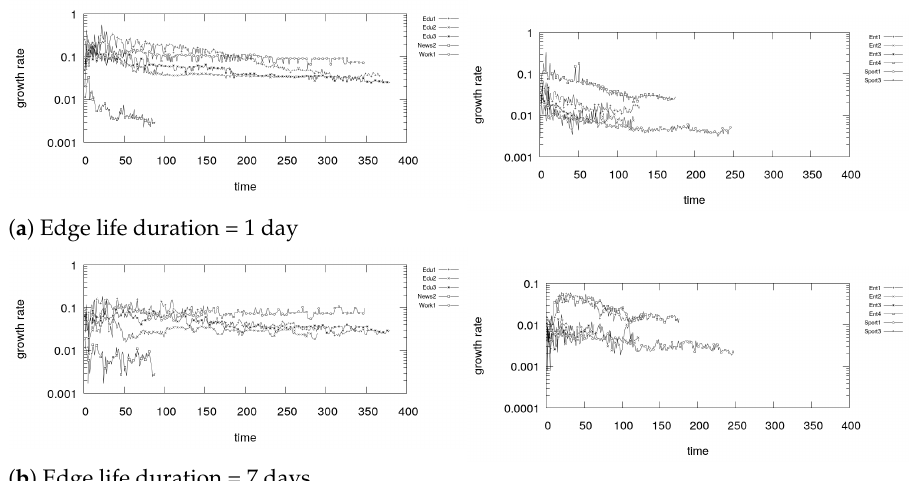
Figure 20. Growth rate of communities detected by K-core.